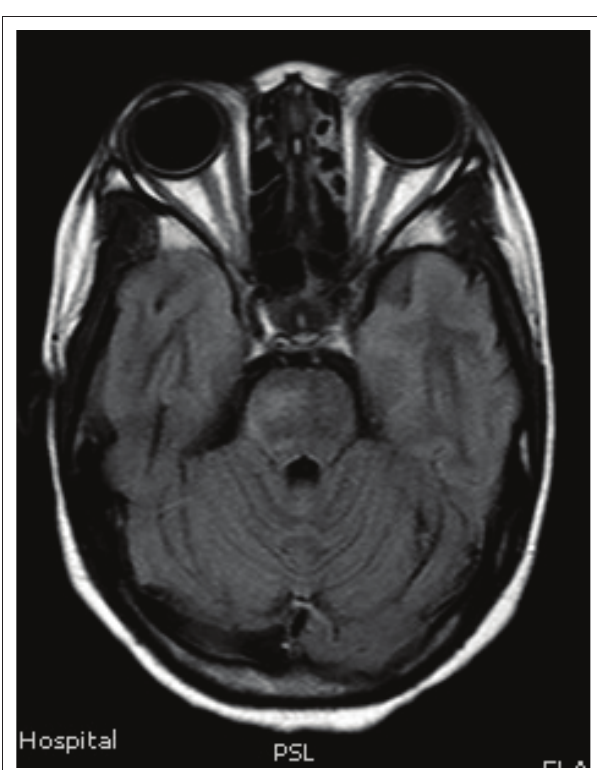
FIGURE 5: Axial fluid-attenuated inversion recovery magnetic resonance showing patchy hyperintensity in the midbrain and depicting faint hyperintensity of the right posterior optic nerve.